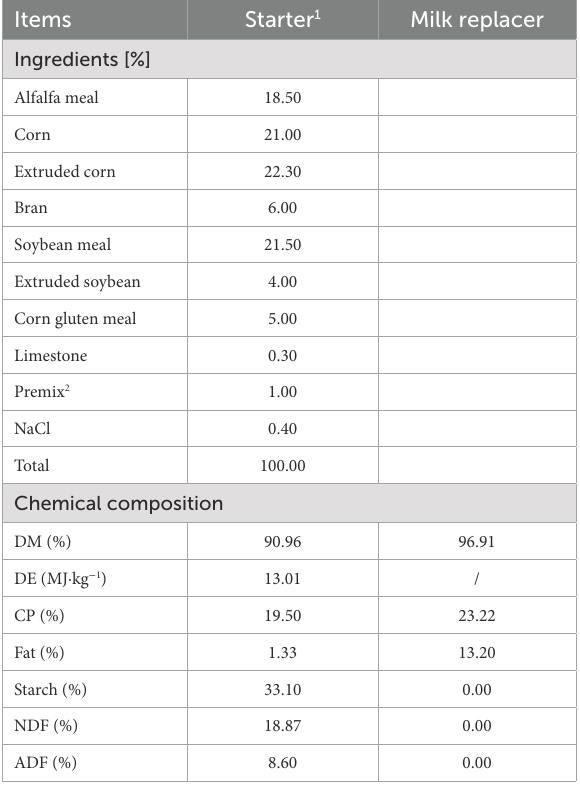
TABLE 1 Ingredients and chemical composition of starter diet and milk replacer (air-dried basis).